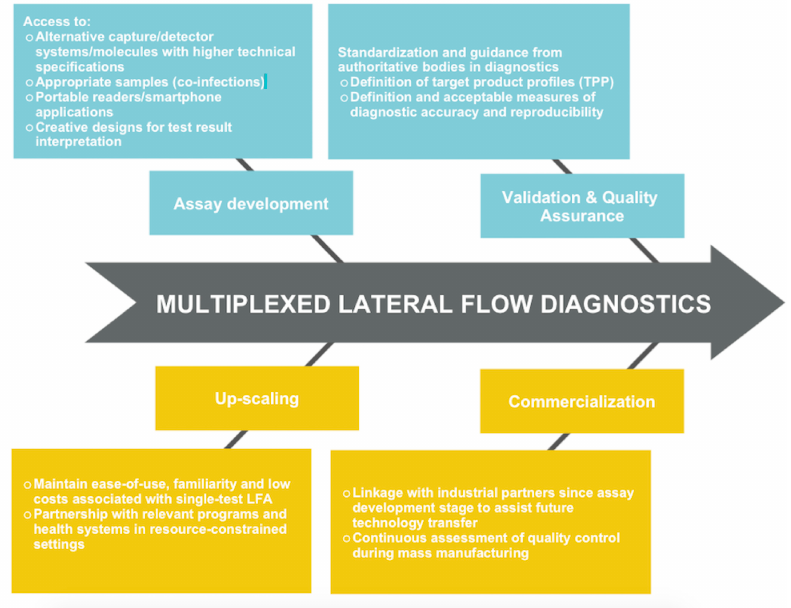
Figure 1. Flowchart of key factors in the path towards translationally viable multiplexed Lateral flow assays (LFA) diagnostics.